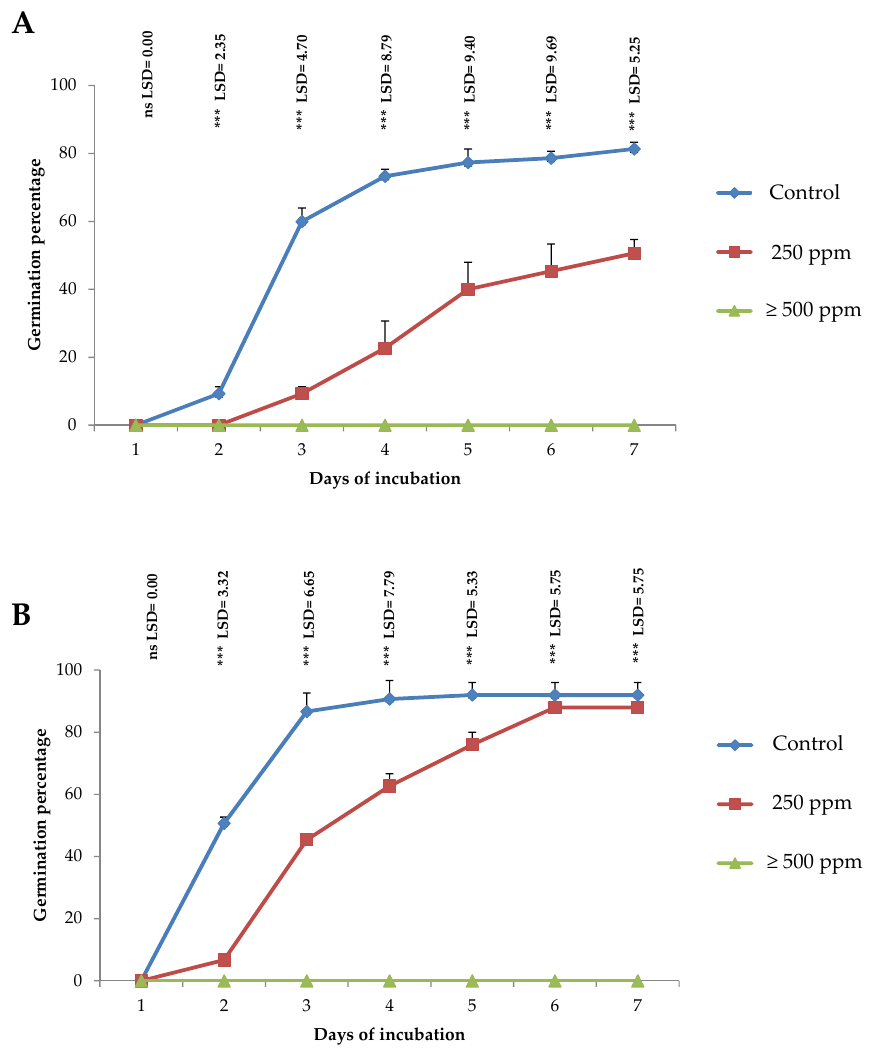
Figure 4. Effect of different concentrations of T. kotschyanus EO (µL/L) on the cumulative germination (mean ± standard error) of Amaranthus retroflexus ( A ) and Panicum miliaceum ( B ). The least significant difference (LSD) indicates the differences between factors.